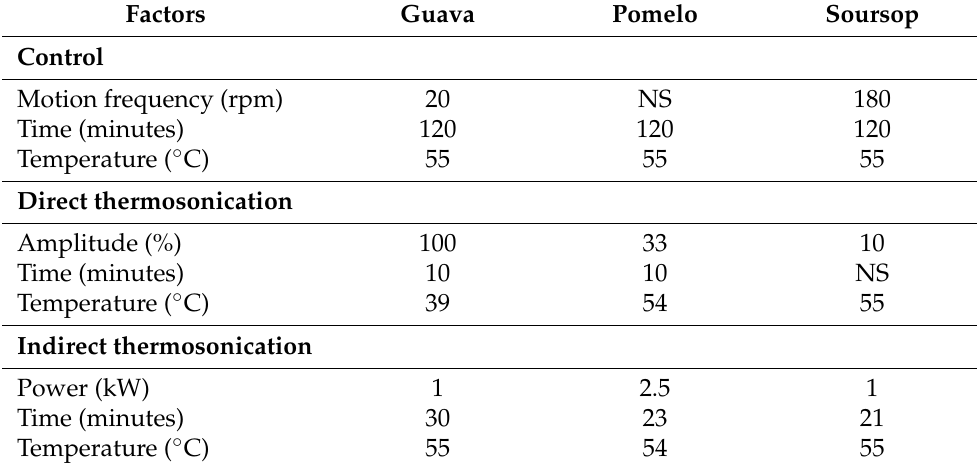
Table 4. Optimum values for extracting tropical fruit